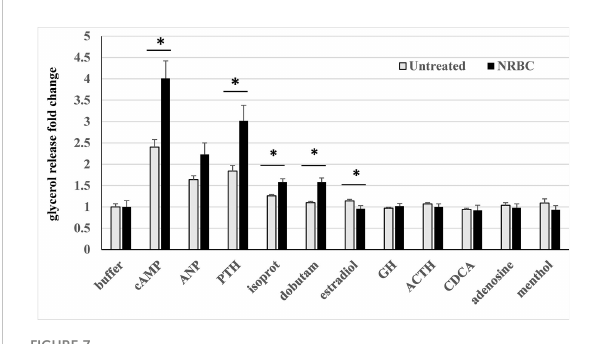
FIGURE 7 Hormone-stimulated lipolysis in white adipocytes (untreated) and NRBC-pretreated cells. After 7d pretreatment with vehicle (untreated) or NRBC, adipocytes were exposed for 4 hours to receptor agonists in KRB buffer. Supernatants were removed for measurement of glycerol. Data are presented as least squares mean ± standard error from experiments using cells from four different donors with BMIs ranging from 27 to 36, each with at least 6 replicates. (*indicates a difference between untreated white adipocytes and NRBC-treated adipocytes p ≤ 0.02) cAMP 8-Cpt- cAMP 200µM, ANP atrial natriuretic peptide 0.1 µM, PTH parathyroid hormone (1-34) 1 µM, isoprot isoproterenol 1µM, dobutam dobutamine 1µM, estradiol 1µM, GH growth hormone 250ng/ml, ACTH adrenocorticotropin hormone 1µM, CDCA chenodeoxycholic acid 30µM, adenosine 1µM, menthol 100µM.